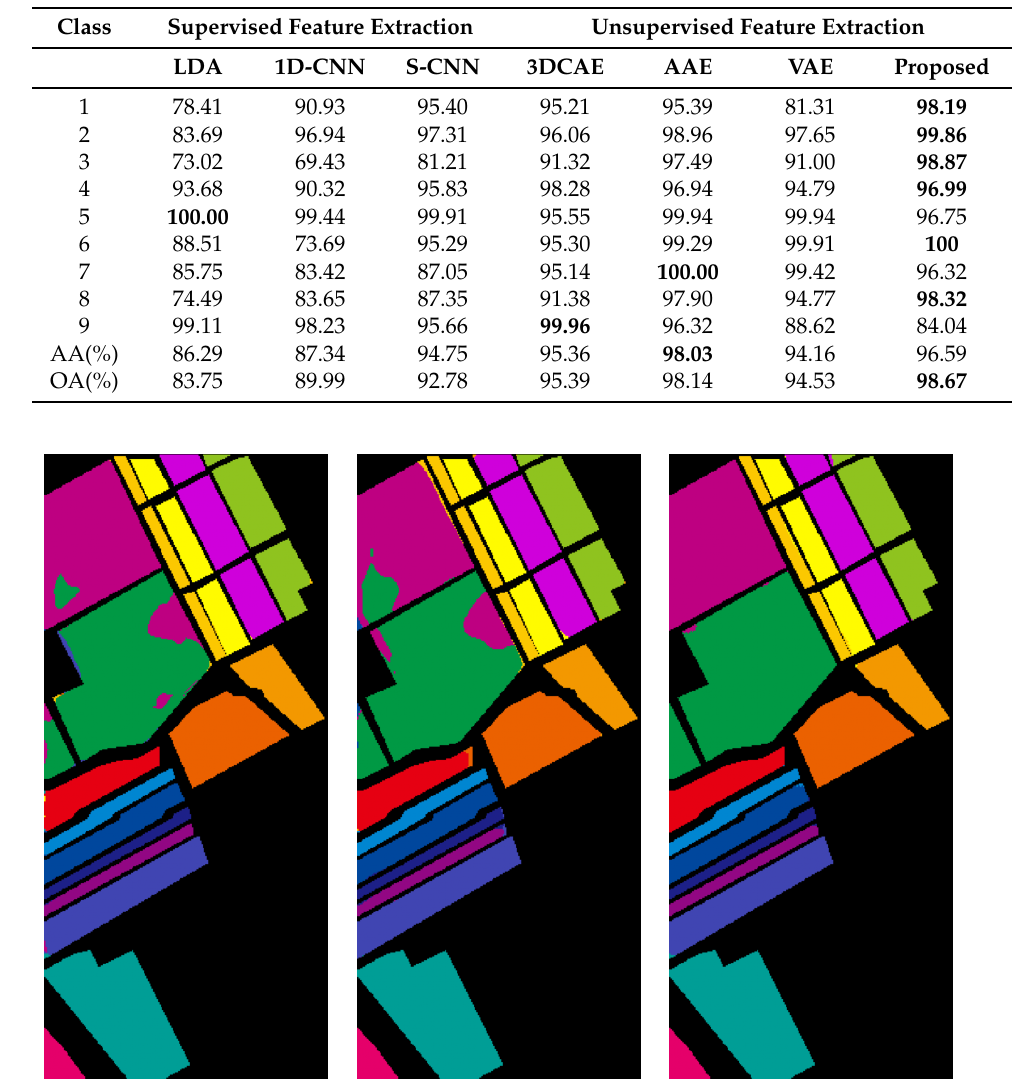
Table 5. Classification results of different models in UP. Some of the data in the table were obtained from [16]. The best values in each row are bolded.